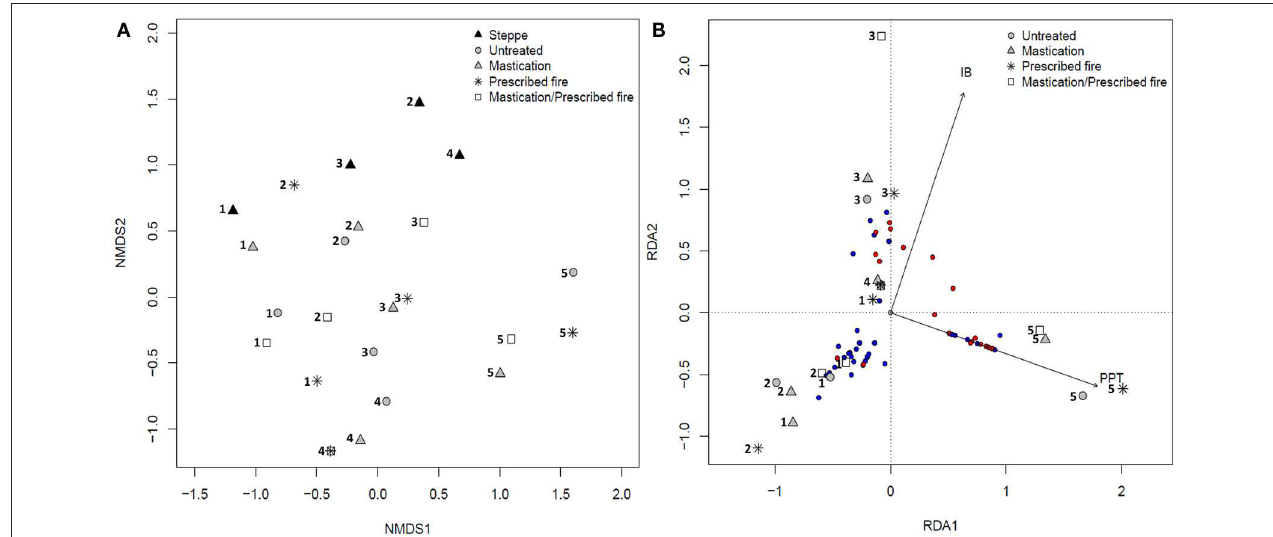
FIGURE 10 | Two-dimensional non-metric multidimensional scaling (NMDS) ordination (A) of vegetation 3 years after fuel reduction implementation in fuel treatments and steppe in all sites (1, 2, 3, 4, and 5) in the two-way factorial design (fuel treatments and steppe × sites); stress = 0.19. Biplot of the first and second axes of the redundancy analysis (RDA) ordination (B) of vegetation 3 years after fuel reduction implementation in fuel treatments in all sites. Circles are species, indicating natives (blue) and exotics (red). Significant explanatory variables are annual precipitation (PPT) and initial residual biomass (IB). Variable covered by the first axis is 9.75%, and that by the second is